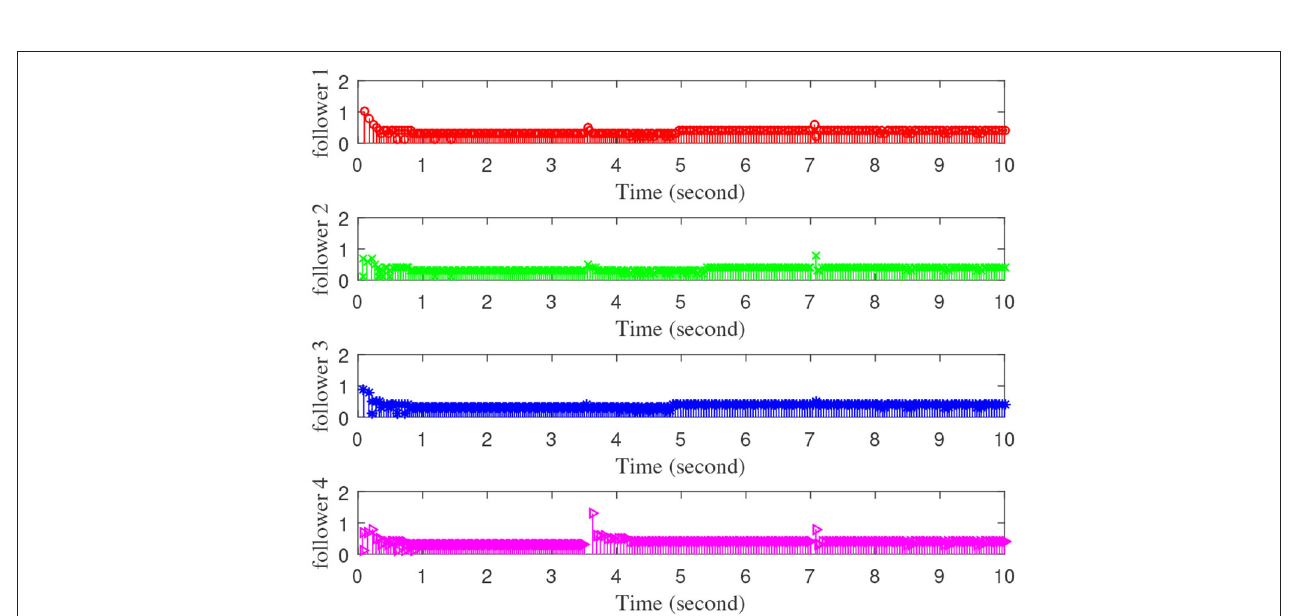
FIGURE 5 | Control input signals of each follower vehicle.